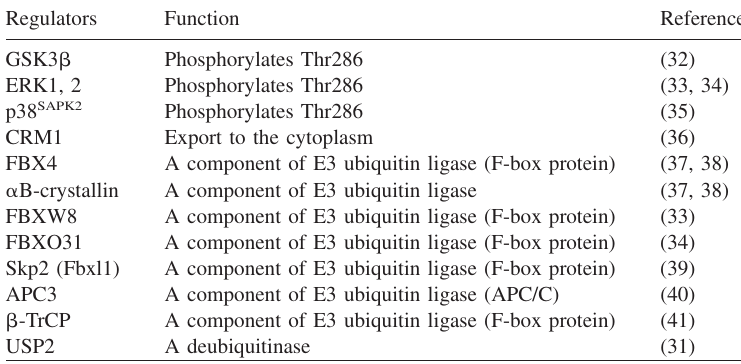
Table 1 Post-translational regulators of cyclin D1